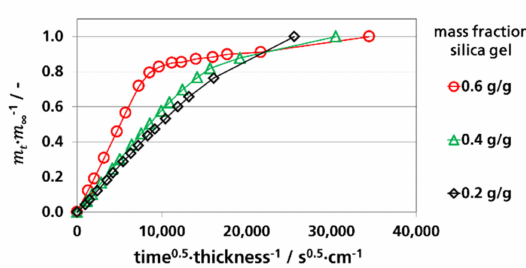
Figure 5. Water vapor absorption of films with dispersed silica gel at 91% RH and 23 ◦ C, determination of D ef f .